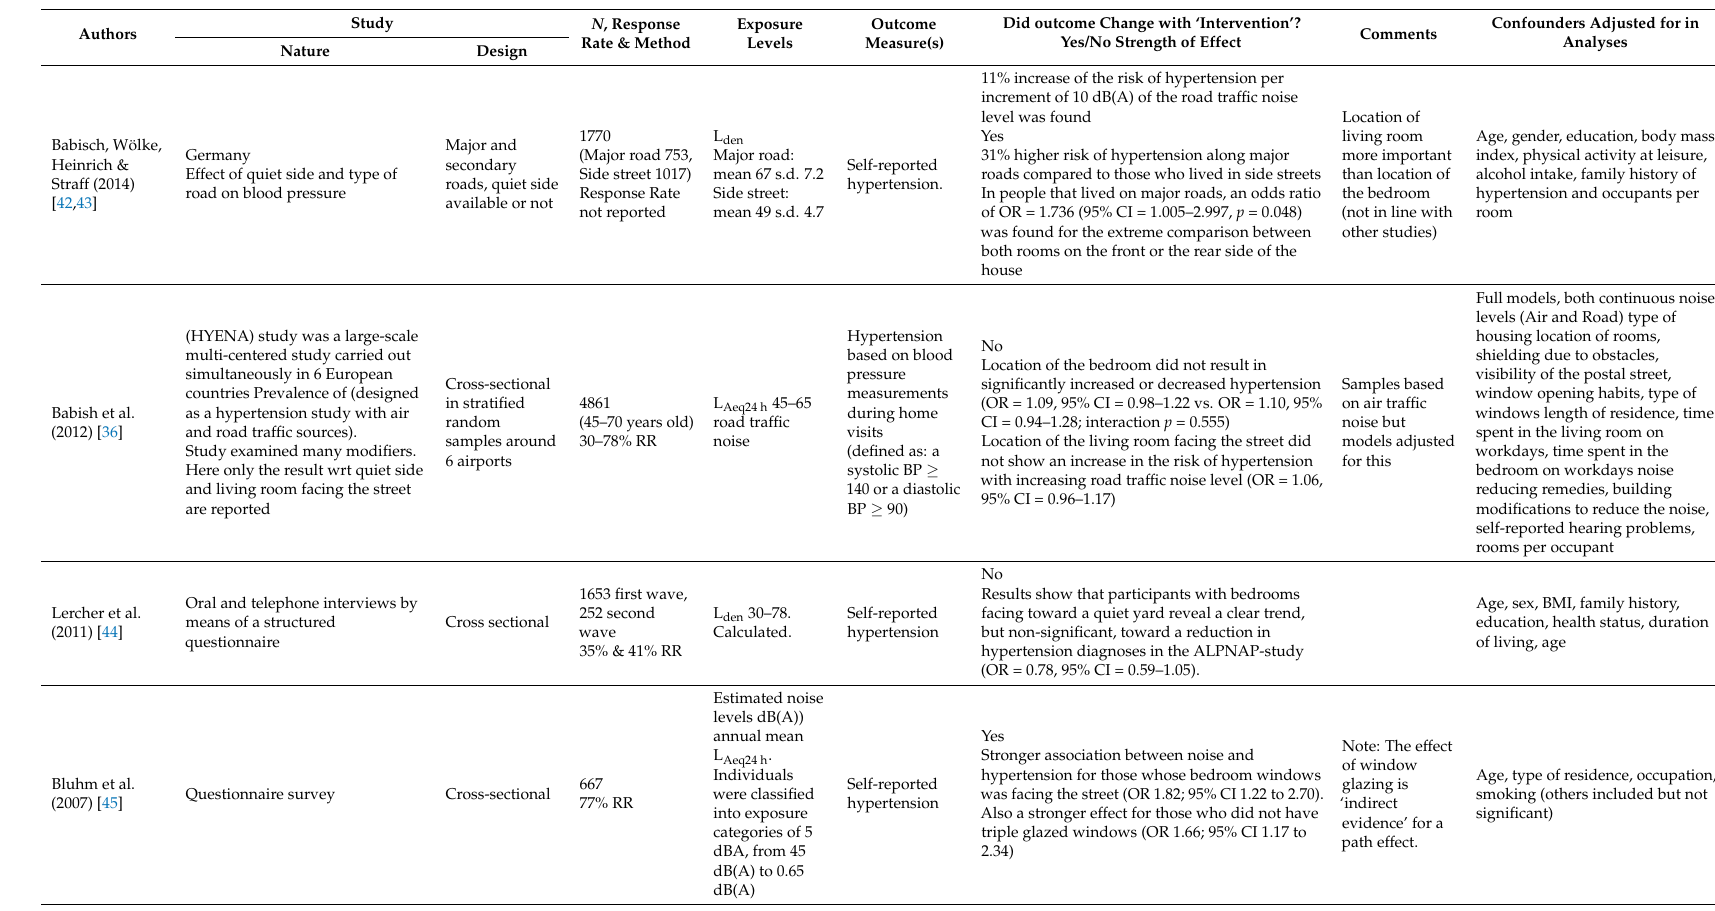
Table 11. Other Physical Intervention (Type